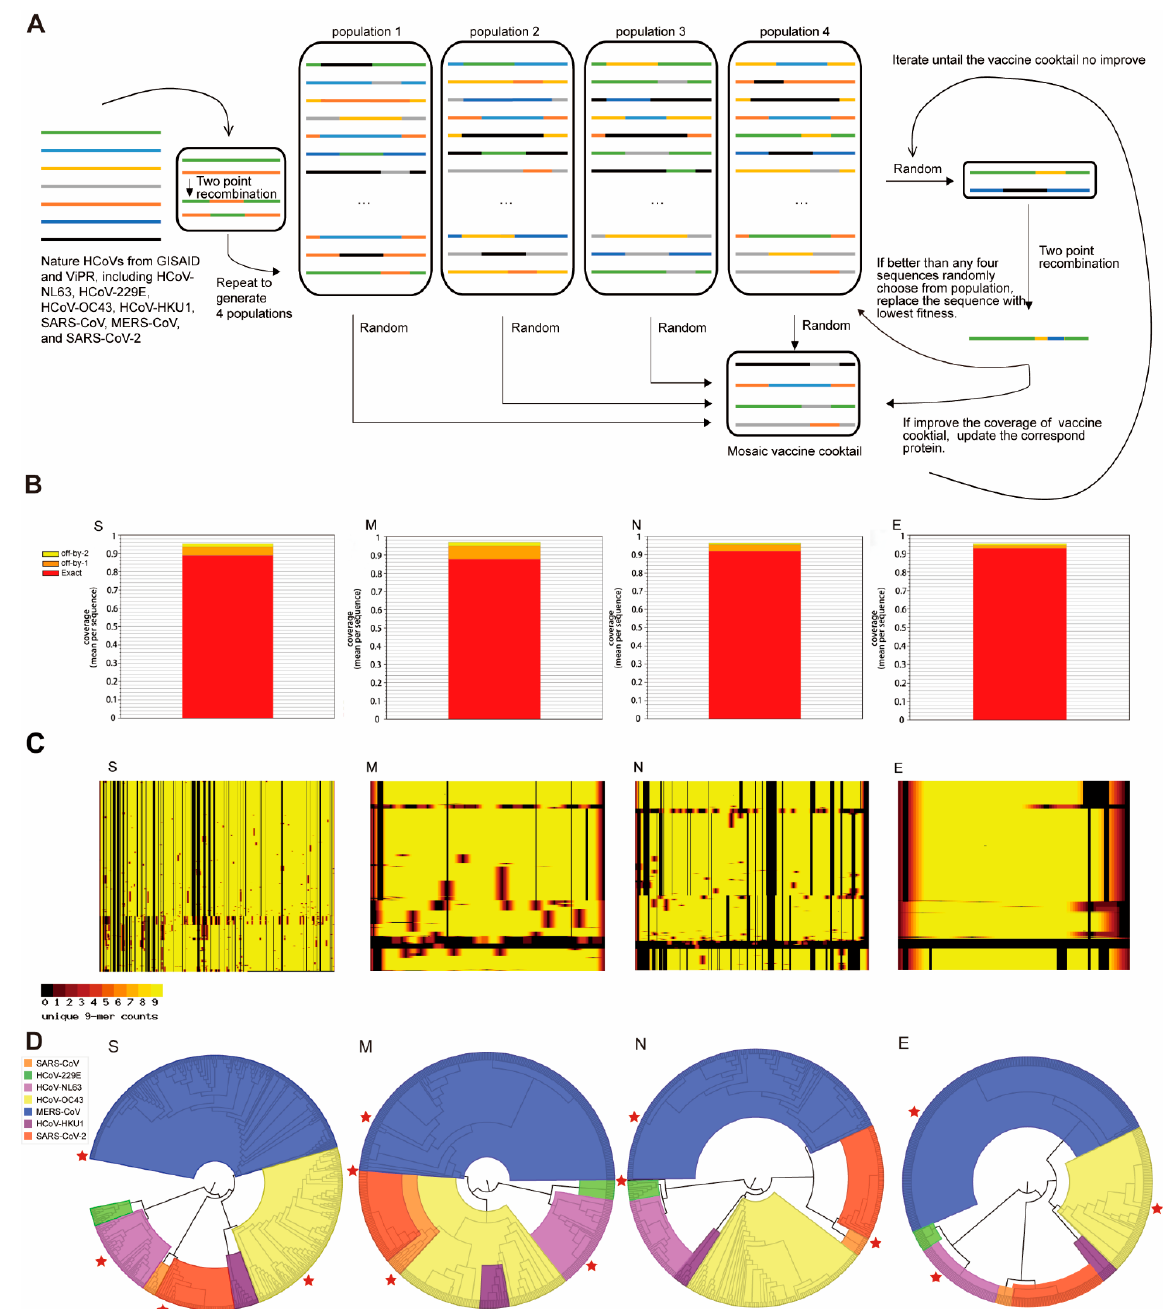
Figure 2. Design of mosaic antigen for a pan-coronavirus vaccine based on conserved CTL epitopes. ( A ) The schema of the genetic algorithm for the generation of a mosaic vaccine from seven species of HCoVs. ( B ) The mean epitope-coverage over the circulating viral proteins sequences covered by the CTL epitope in mosaic cocktail. The results indicated coverage (mean per-sequence) of S protein, M protein, N protein, and E protein. ‘Exact’ represents a 100% match, 9 AA out of 9 AA; ‘off-by-1’ indicates a match at 8AA out of 9 AA; ‘off-by-2’ indicates a match at 7AA out of 9 AA. ( C ) The alignment of the epitopes in mosaic antigens with their counterparts in pro- teins found in circulating virus using the Positional Epitope Coverage Assessment Tool. Each col- ored square includes an alignment of amino acid. Each “row” represents an amino acid sequence of the protein in the block. The column represents the relative position of a specific epitope. If a 9- aa in mosaic antigen makes a 100% match to their counterpart found in the vaccine or circulating